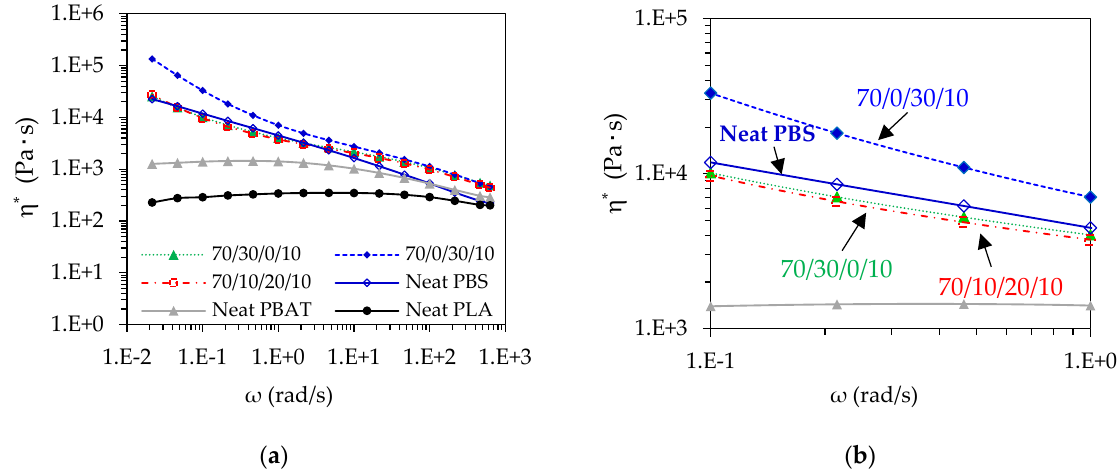
Figure 5. Complex viscosity ( η ∗ ) of neat polymers and PLA/PBAT/PBS/nano talc composites measured at 210 ◦ C: ( a ) Full image; ( b ) Enlarged image of ( a ).